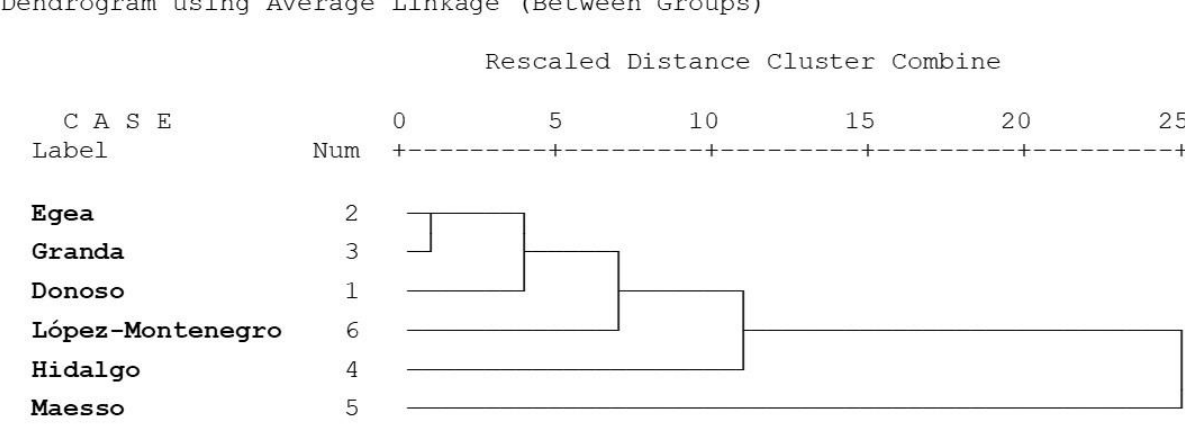
Figure 2. Dendrogram using Average Linkage between genetic lines.